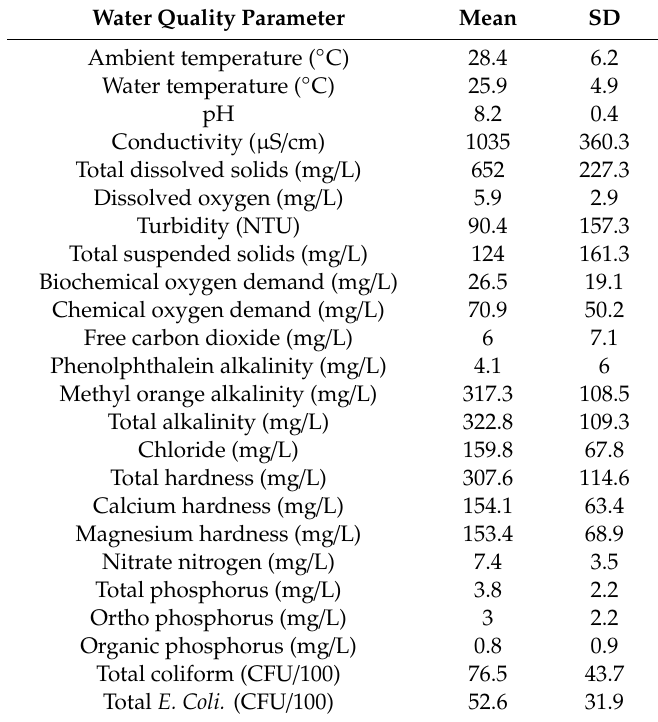
Table 5. Average values (standard deviation) of water quality parameters of the Kshipra river in India in various seasons and at various sites over a 3-year